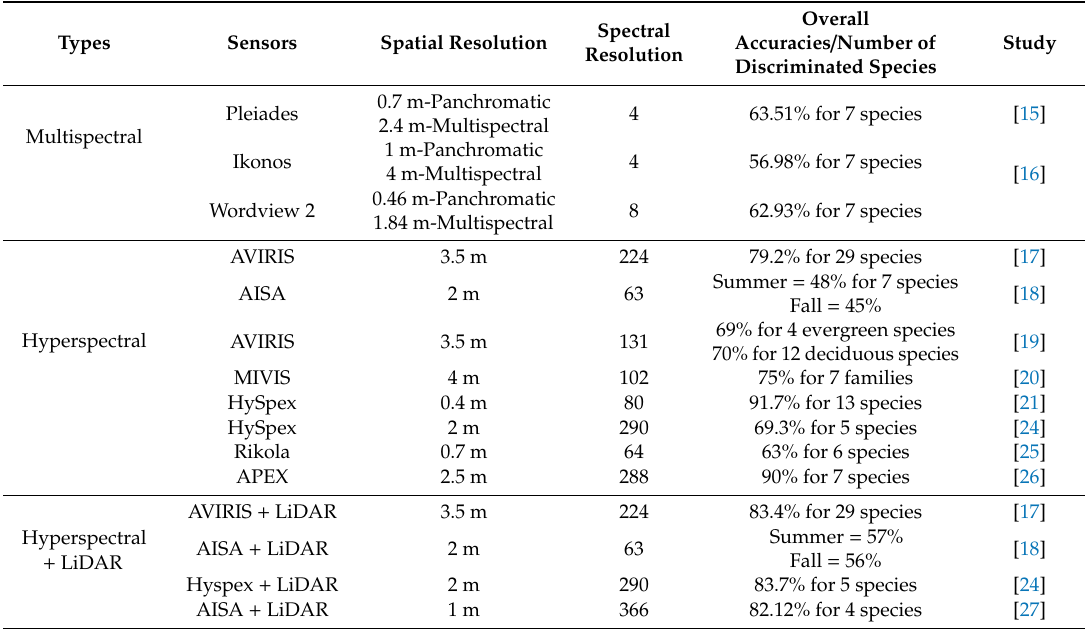
Table 1. State of this art of VHSR multispectral and hyperspectral images capabilities to discrimination of trees species in urban